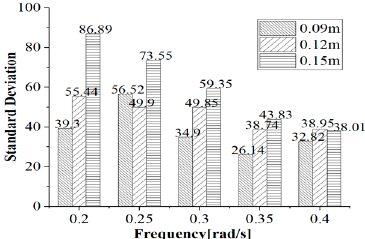
Figure 18. Standard deviation of surge response at different frequencies.